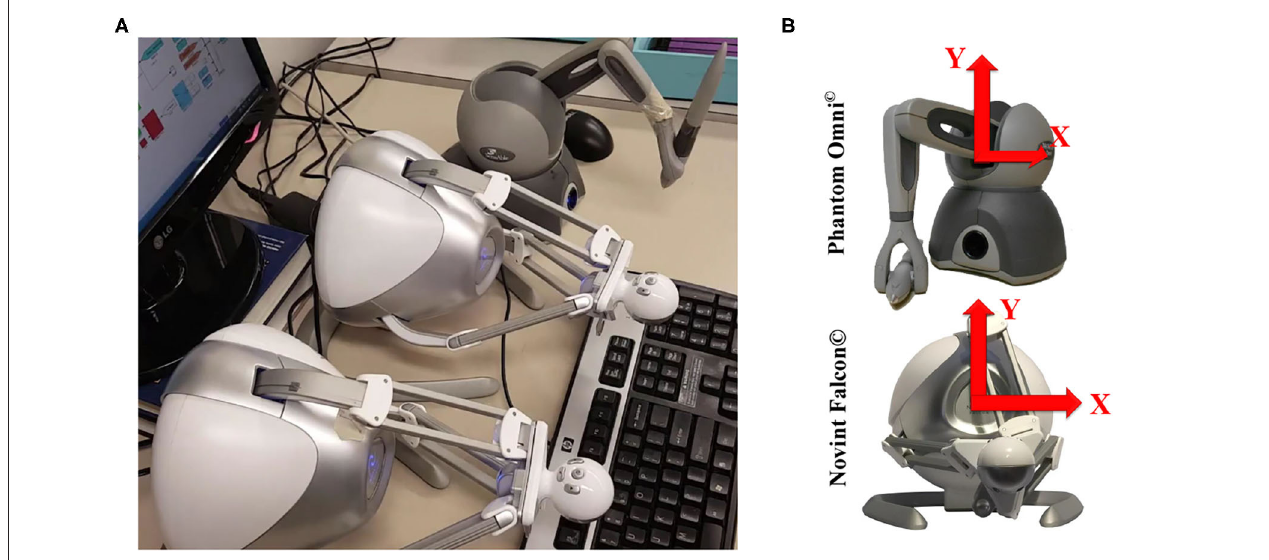
FIGURE 7 | Implementation of the HTS. In part (A) , the overview of three non-homogeneous robots, two of which are Novint Falcon © and one Phantom © , is shown. The X and Y coordinate frames, which represent two-dimensional motion, are assigned to them in part (B) .